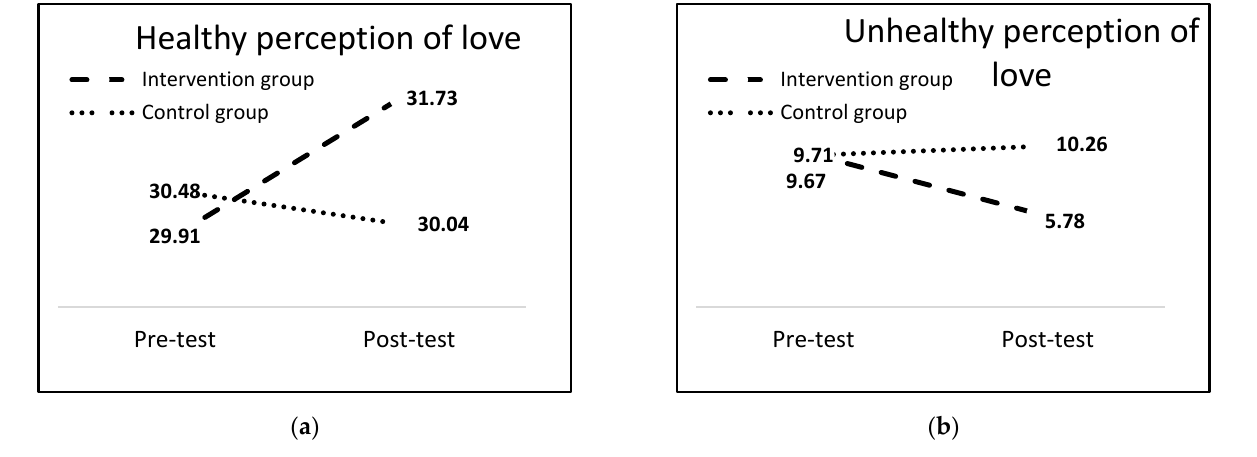
Figure 1. Means obtained by the groups (intervention and control) on healthy perception of love ( a ) and unhealthy perception of love ( b ).